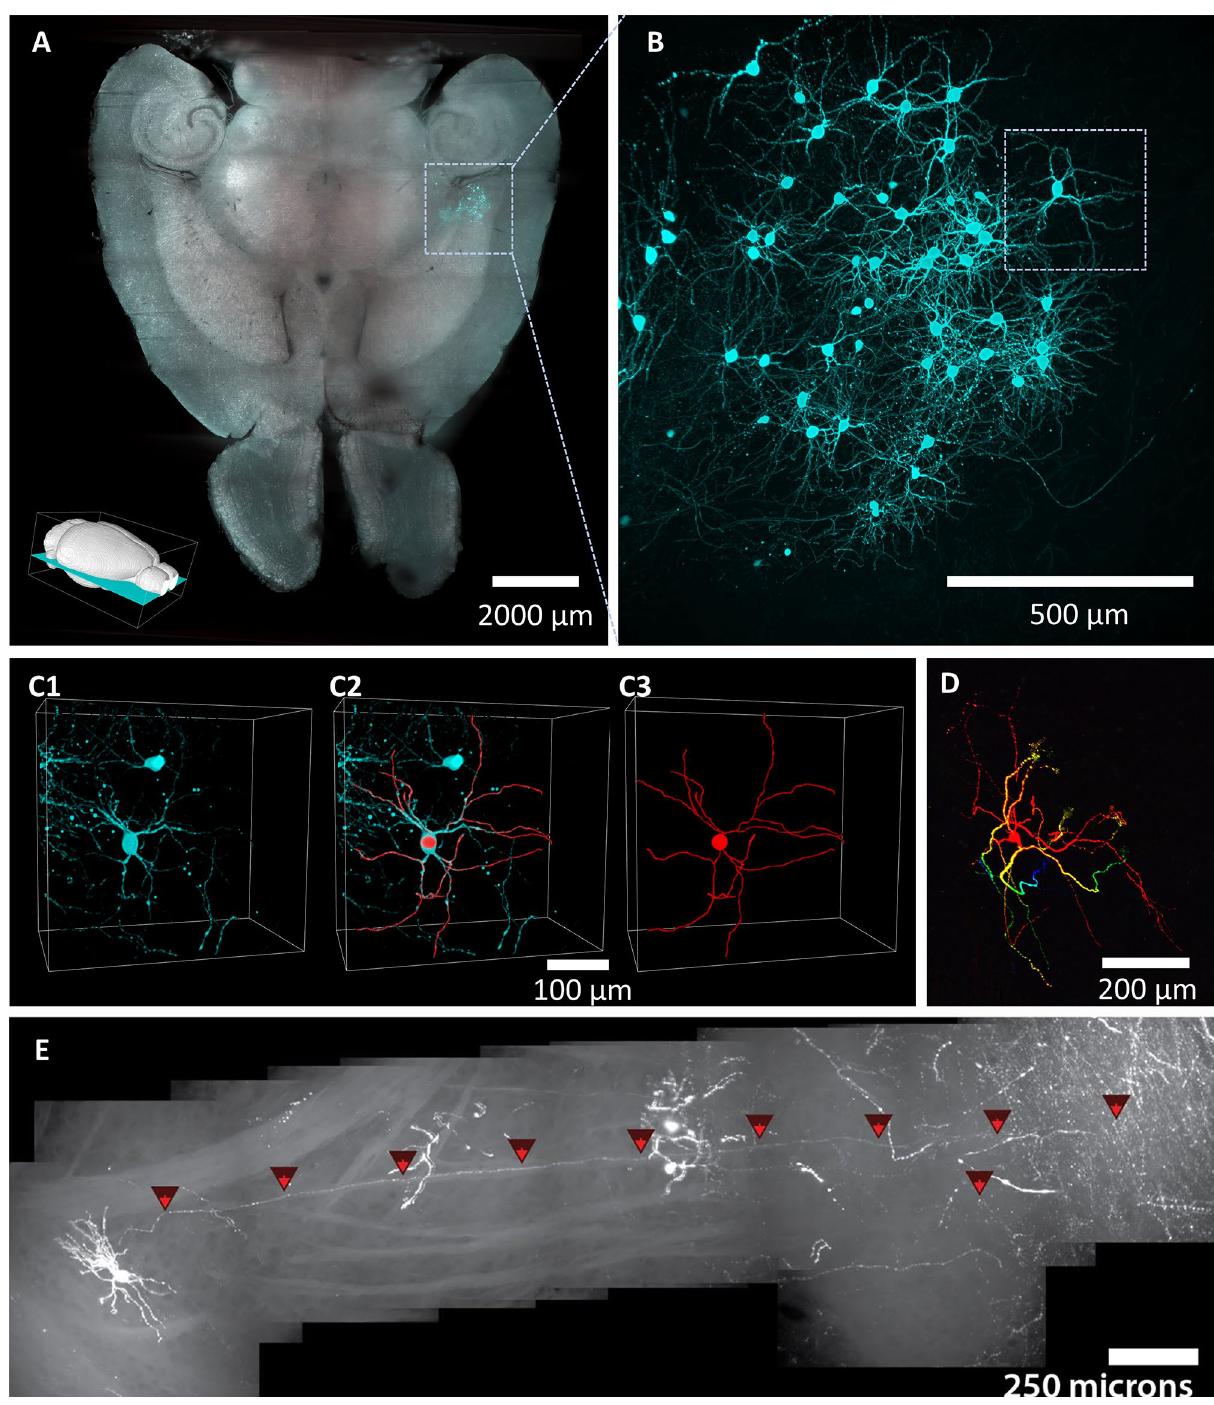
Figure 3. Light sheet microscopy with MHD-cleared tissue. ( A ) Optical slice of an intact mouse brain cleared using MHD-accelerated clearing (horizontal orientation; inset: position of slice). GFP-labeled cells (cyan) are clear in the medial amygdala. ( B ) Higher magnification image corresponding to the location of the dashed box in panel A showing individual cells and associated neural processes are visible deep within the tissue. ( C ) Higher magnification corresponding to the dashed box in panel B showing an isolated GFP-expressing neuron in the MeA (left), traced neural processes (right), and overlay of the fluorescent image and trace (center). ( D ) A depth color-coded projection of a single GFP-expressing neuron cell inside the brain (100 µm depth for projection; red: closest; blue: farthest). ( E ) Single axon traced from cell body to axon terminals through several millimeters of brain tissue inside the intact brain. The cells shown in ( D ) and ( E ) are not from the same sample as in ( A ) through ( C